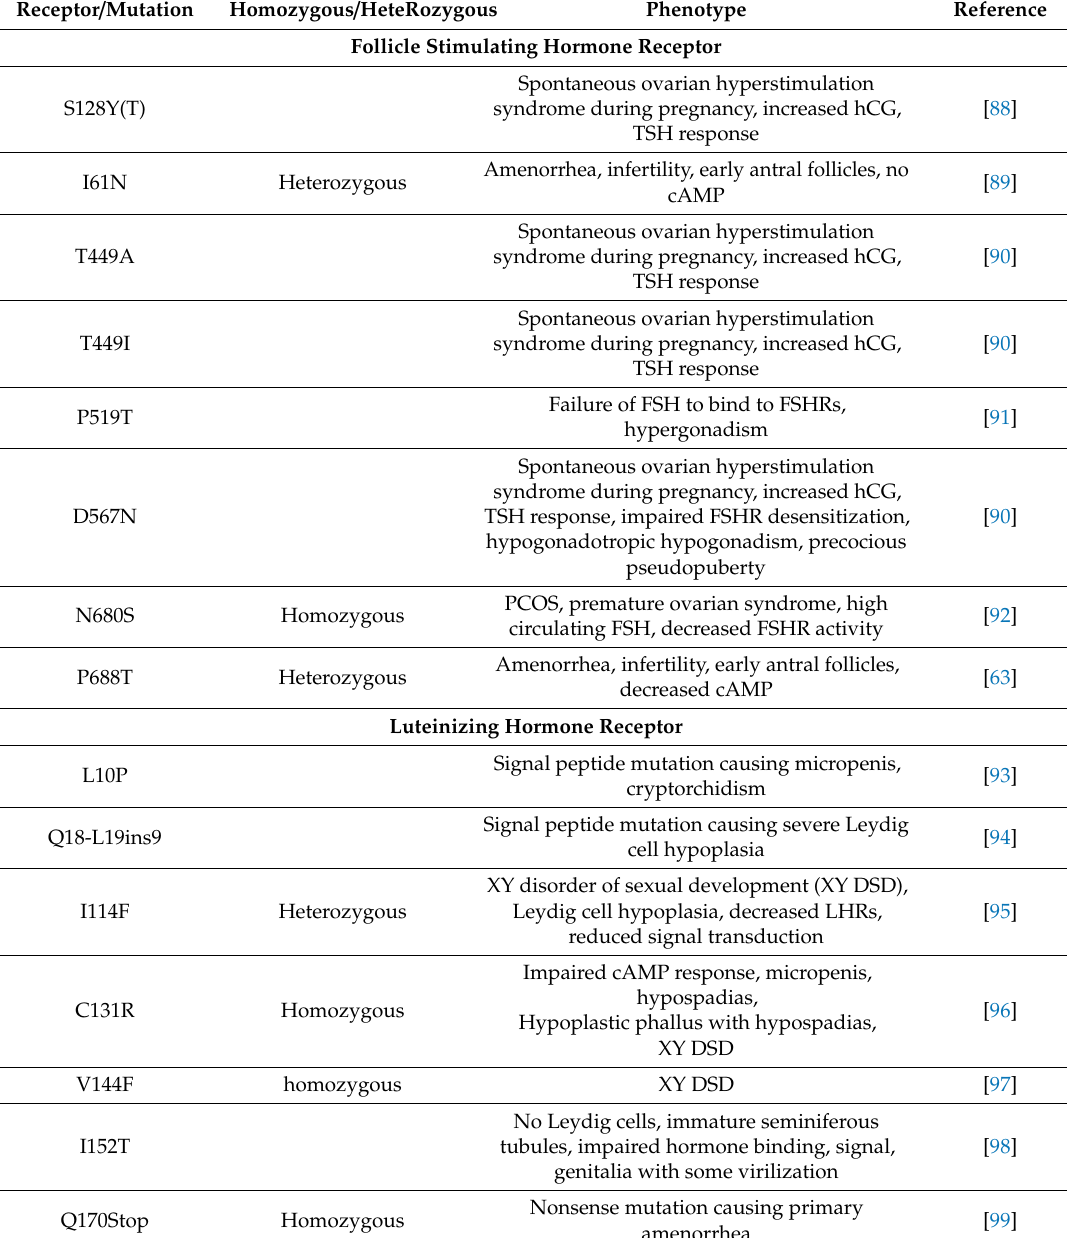
Table 2. Mutations in FSHRs and LHRs associated with altered receptor function and